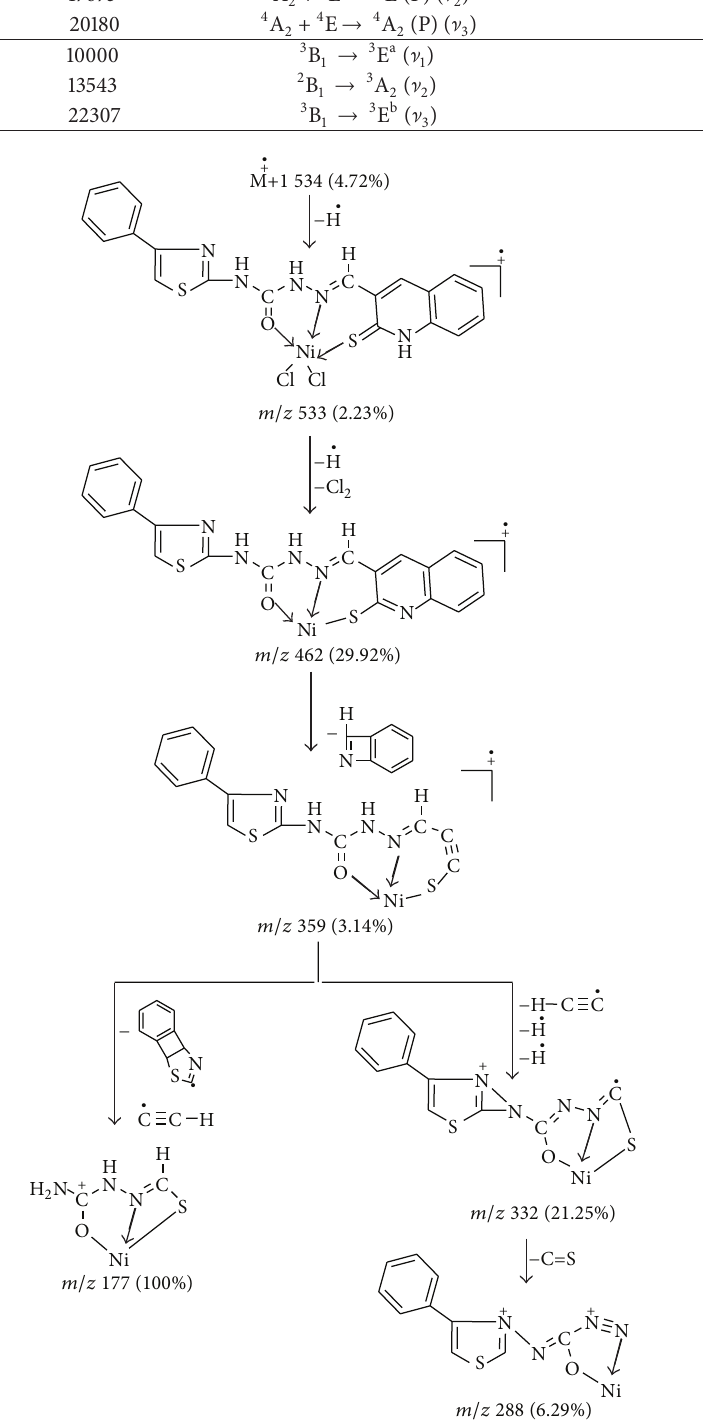
Scheme 4: Mass fragmentation pattern of Ni(II)